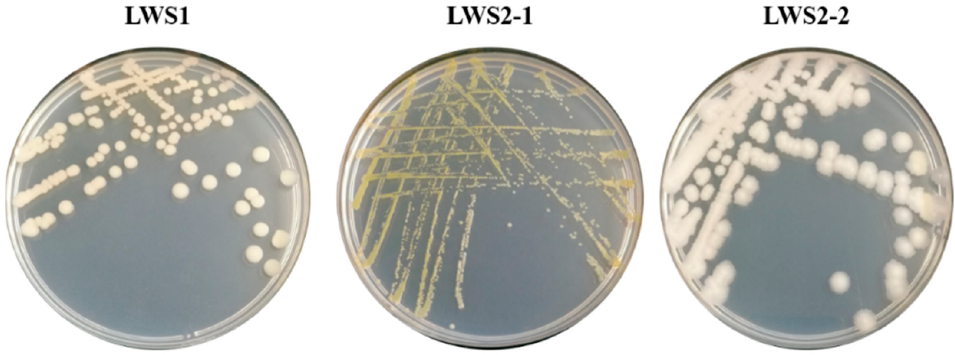
Figure 1. The colony morphology of the three bacterial strains isolated from Se tailing soil. The strains were grown on LB agar medium containing 100 mg·L − 1 SeIV. To further identify the taxonomic level of strain LWS1, its 16S rRNA gene sequence was aligned with the known sequences retrieved from the NCBI database. As shown in Figure 2, the 16S rRNA gene of strain LWS1 shared high similarity with several species of the genus Bacillus , with the highest BLAST scores (100%) observed in Bacillus sp. (in: Bacteria) IC-1C2 (MT649293.1). Compared with previous studies, the colony morphology of strain LWS1 showed the typical properties of B. megaterium [44], which was recently reclassified as Priestia megaterium [45]. Therefore, we preliminarily speculated that the bacterium was a new strain of Priestia , namely, Priestia sp. strain LWS1.